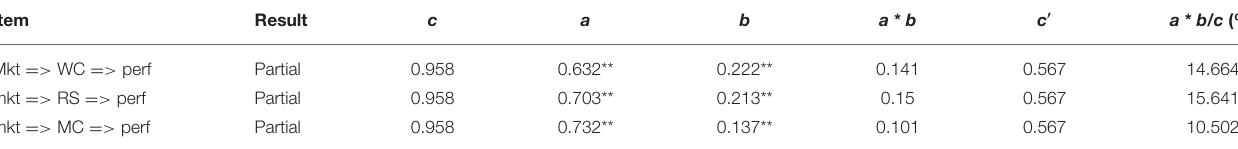
TABLE 8 | Results for the intermediate